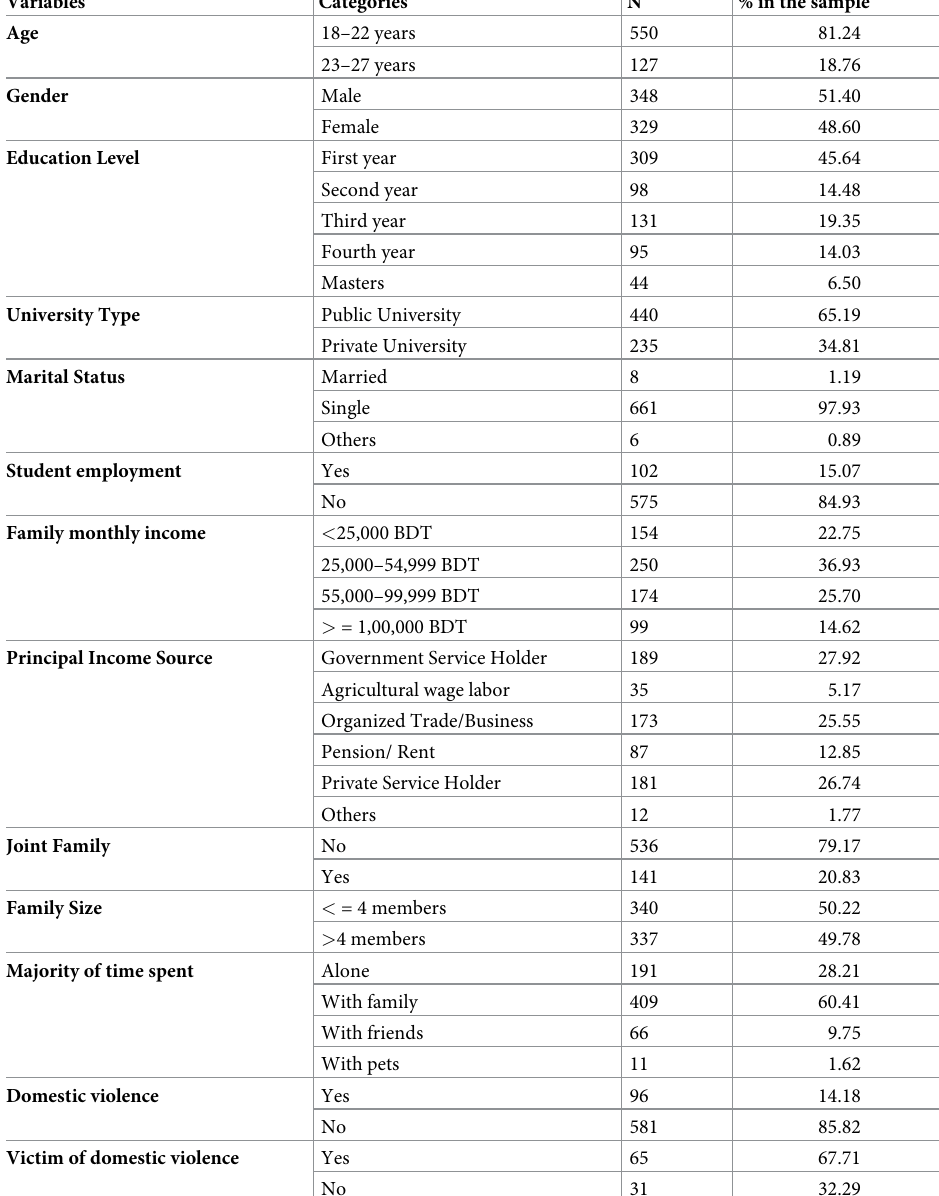
Table 1. Socio-demographic